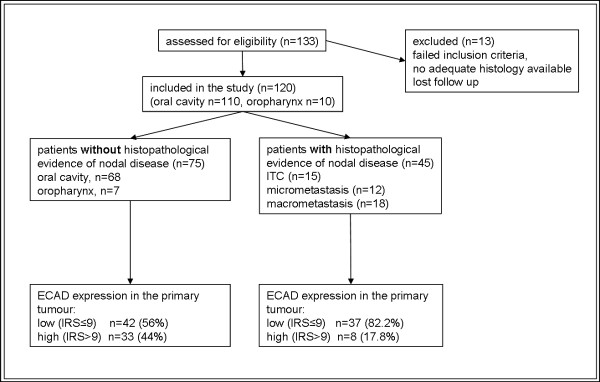
Consort Diagram of the patients included in the study. ECAD = E-Cadherin; IRS = Intensity Reactivity score; ITC = isolated tumour cells